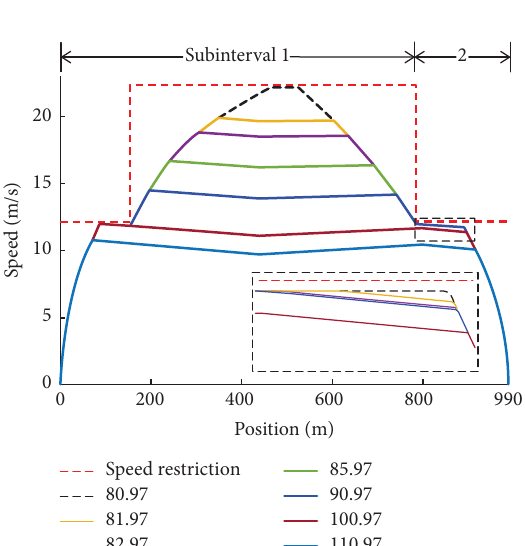
Figure 9: Te illustration of T-CC with diferent running times from S